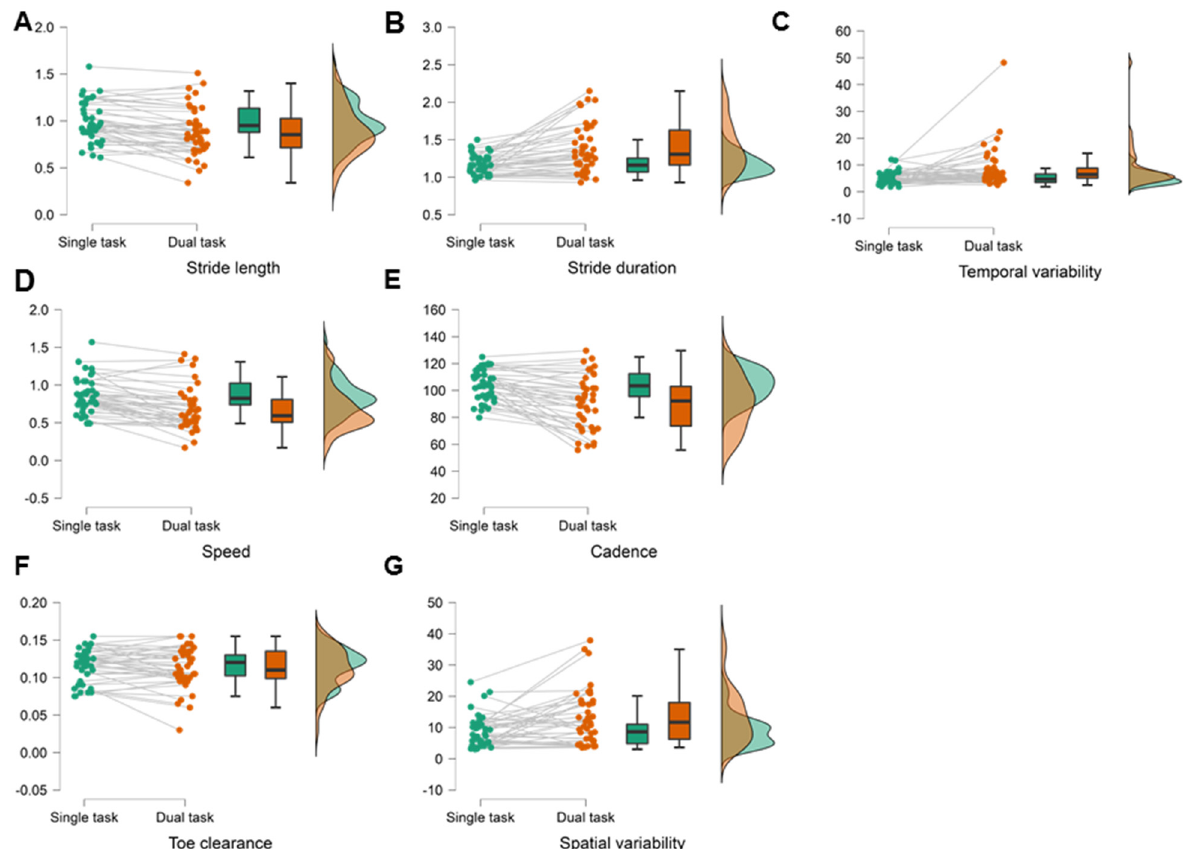
Figure 1. Changes of gait parameters between single- and dual-task condition. ( A ) stride length decreased ( p < 0.001), ( B ) stride duration ( p < 0.001) increased, ( C ) temporal variability ( p < 0.001) increased, ( D ) speed ( p < 0.001) decreased, ( E ) cadence decreased ( p < 0.001), ( F ) toe clearance ( p = 0.405) remained unchanged, ( G ) spatial variability ( p = 0.003) increased under dual task with highest effect size for speed.